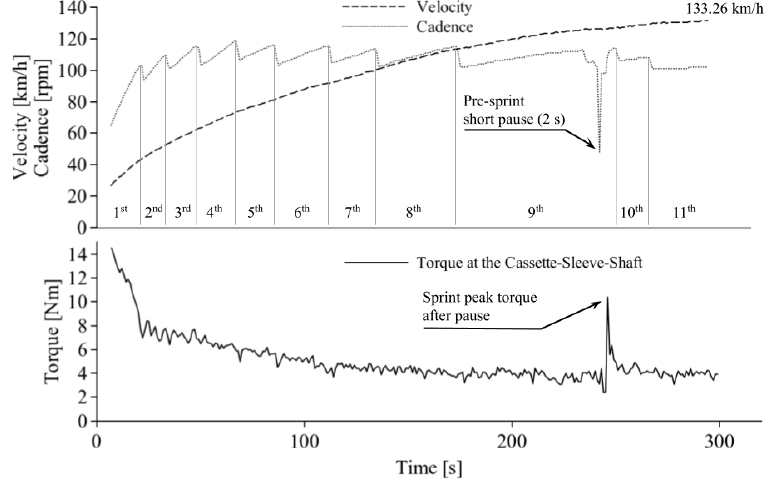
Figure 8. Velocity, cadence and cassette torque from 2018 race data analysis.